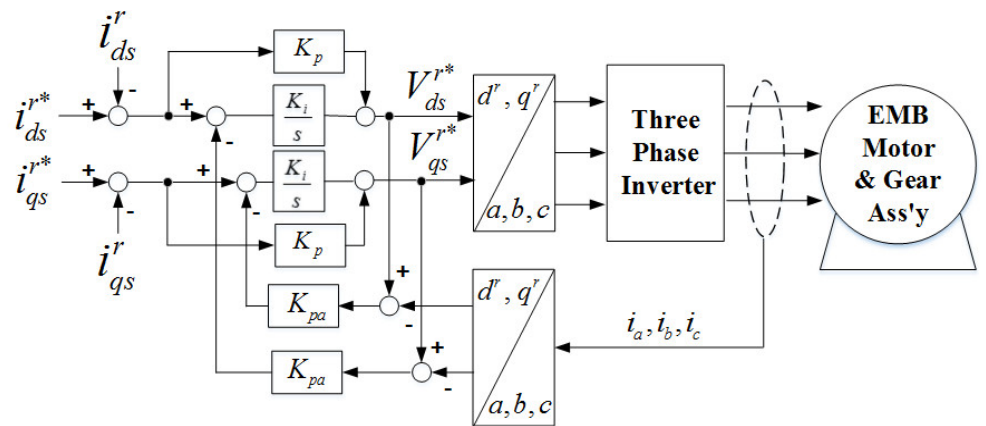
Figure 13. Concept diagram for proposed PI controller using anti-windup feedback control.